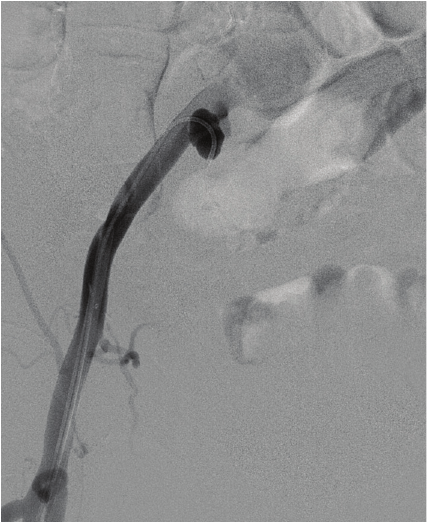
Figure 2: False aneurysm of the right common iliac artery demonstrated.